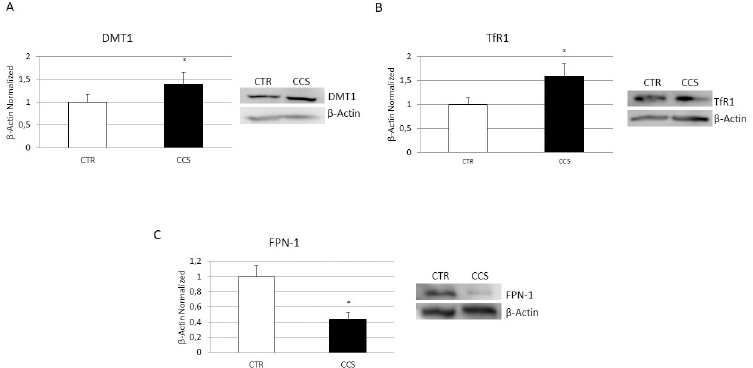
Fig 4. Iron metabolism in OCs derived from CCS. Protein expression of DMT1 (A), Transferrin Receptor 1, TfR1 (B), Ferroportin, FPN1 (C) in OCs from 5 Childhood cancer survivors (CCS) compared with OCs from 5 healthy subjects (CTR), determined by Western Blot starting from 15 μ g of total lysate. The most representative images are showed. The Image Studio Digits software has been used for the protein bands density detection. The intensity ratios of immunoblots compared to CTR, considered as 1, were quantified after normalization with the housekeeping protein β -Actin. Histogram show the relative quantification for DMT1, TfR1 and FPN-1 as mean ± SD of independent experiments on each individual sample. For statistical analysis it has been used a t-test. � Indicates p � 0.05 compared to CTR.